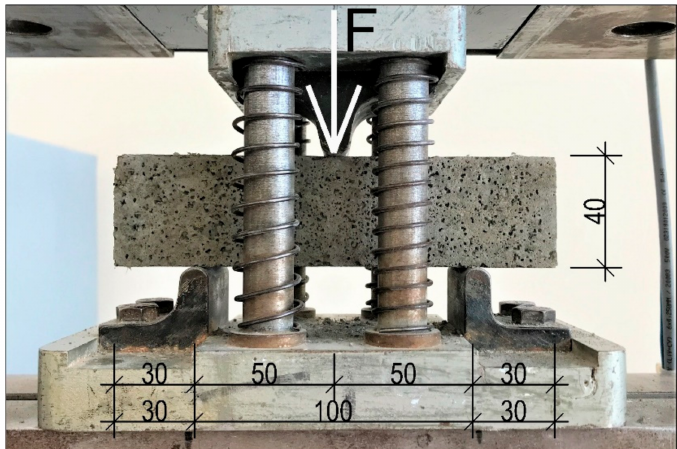
Figure 3. Test stand, dimensions in mm. Each dimension of the specimen was measured with the use of a digital calliper (with accuracy of 0.01 cm) before placing it on the test stand. Specimens were submitted to static load with the speed ratio maintained at 1.5 mm/min. The maximum values of the load were determined for each specimen, and then flexural strength f cf was calculated. Analysis of the bridging effect during the post-critical stadium (after gaining the